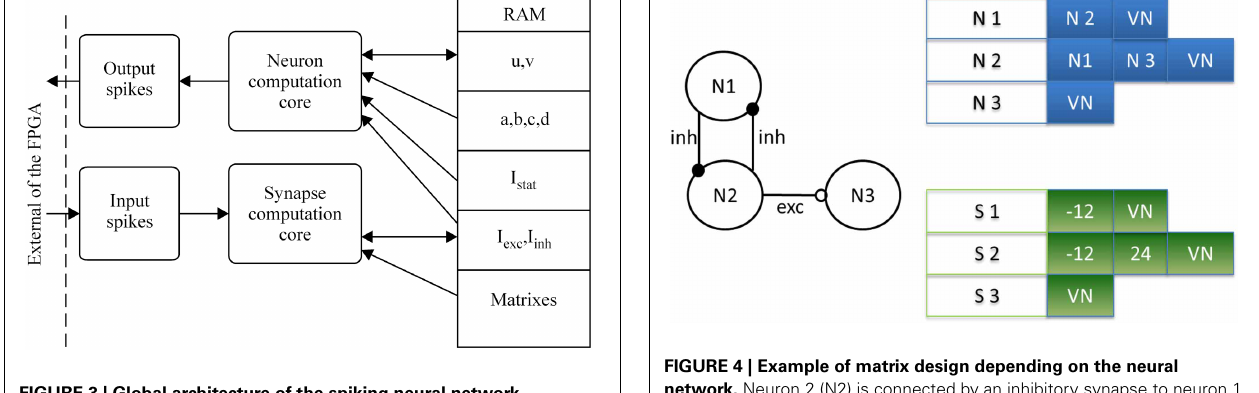
FIGURE 3 | Global architecture of the spiking neural network. Table 1 | Description of the equations for synaptic currents and activity-dependent depression.